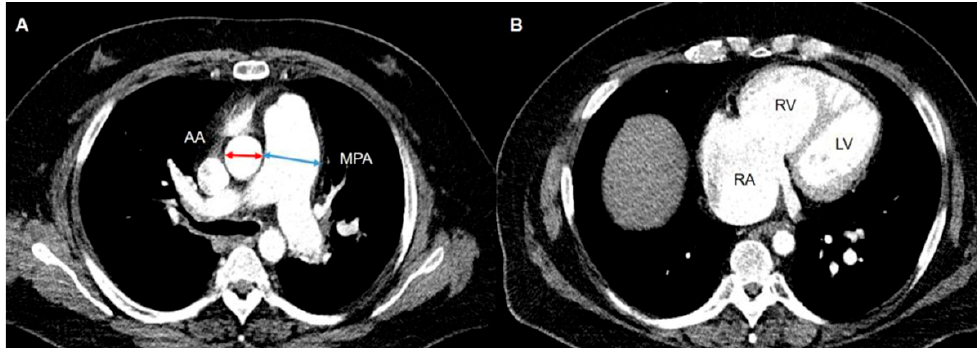
artery (MPA). The ratio of the MPA diameter to that of the ascending aorta (AA) is greater than 1. ( B ) CT scan obtained at a lower level shows RV dilatation. The ratio of the RV diameter to the LV diameter is greater than 1 at the midventricular level. Abbreviations: AA, ascending aorta; LV, left ventricle; MPA, main pulmonary artery; RA, right atrium; RV, right